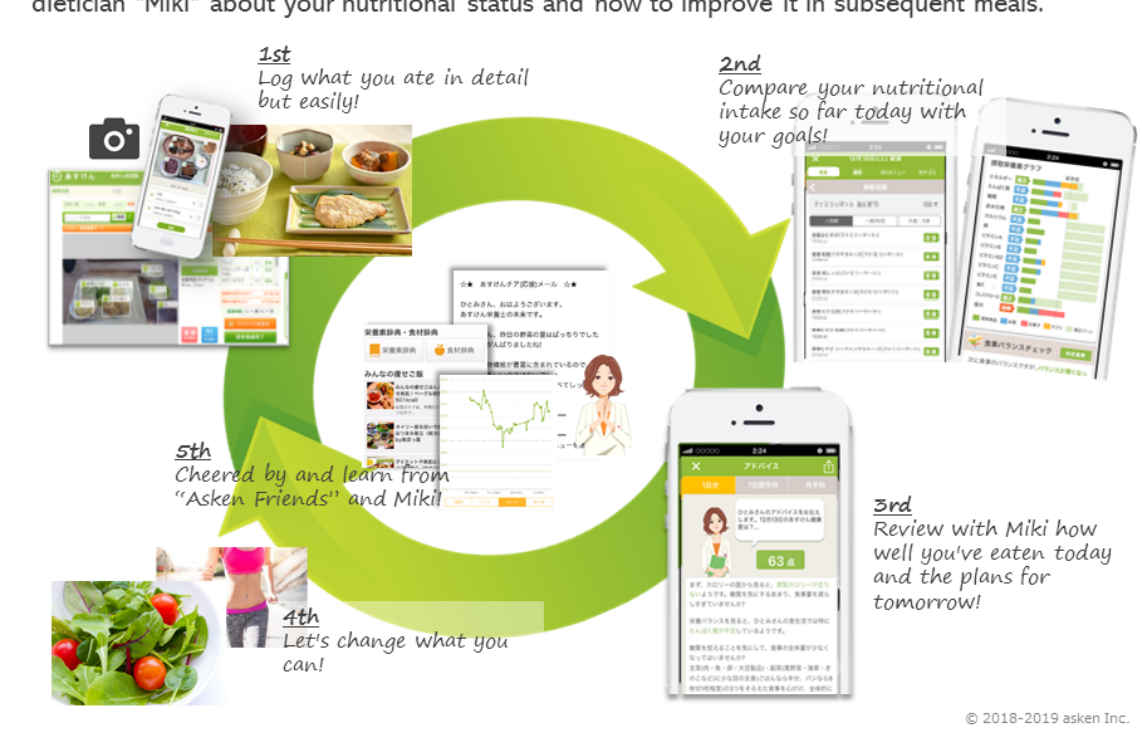
Figure 1. Details of the asken